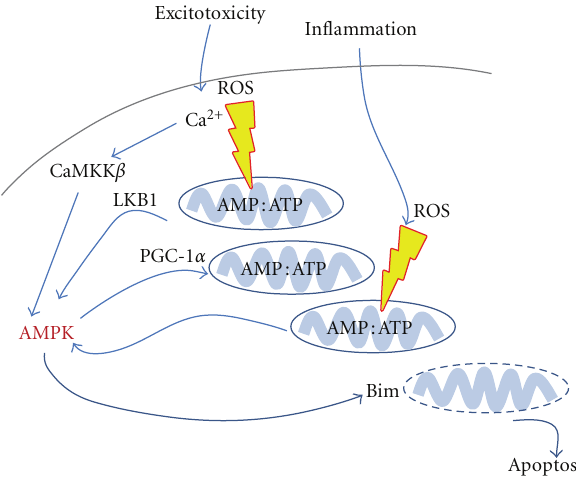
Figure 1: A potential role for AMPK in neonatal brain injury. AMPK is activated in response to stresses which change either intracellular calcium levels (e.g., excitotoxicity) or deplete intra- cellular ATP concentrations (e.g., inflammation, reactive oxygen species). Although AMPK works to return energy levels to baseline, prolonged activation results in upregulation of the proapoptotic protein,